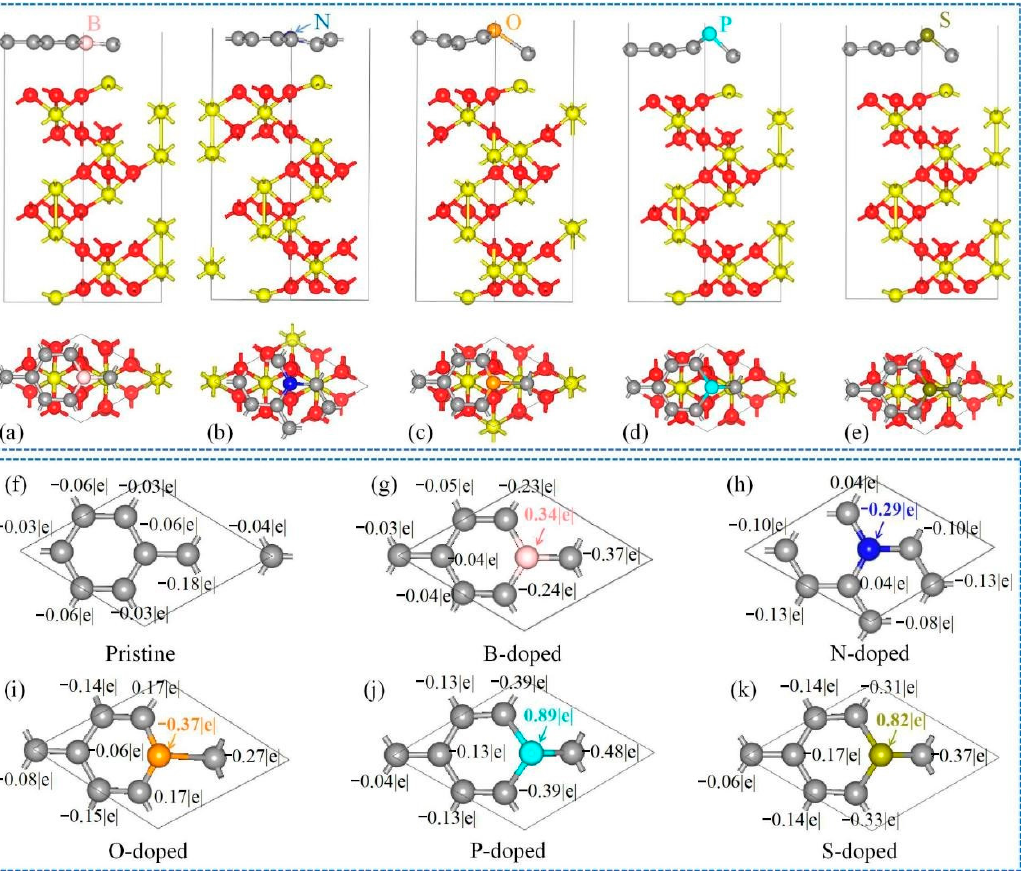
Figure 6. ( a ) Optimized structures for ( a ) B-, ( b ) N-, ( c ) O-, ( d ) P-, or ( e ) S-doped Gr/Fe-O 3 -Fe-R system; ( f – k ) transferred electrons of Gr in ( f ) Gr/Fe-O 3 -Fe-R and ( g – k ) M-doped Gr/Fe-O 3 -Fe-R (M = B, N, O, P, and S) systems.